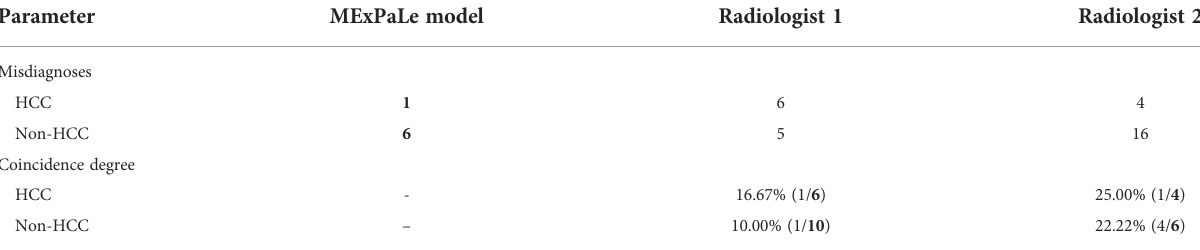
TABLE 6 Misdiagnosed images for model and radiologists ’ classi fi